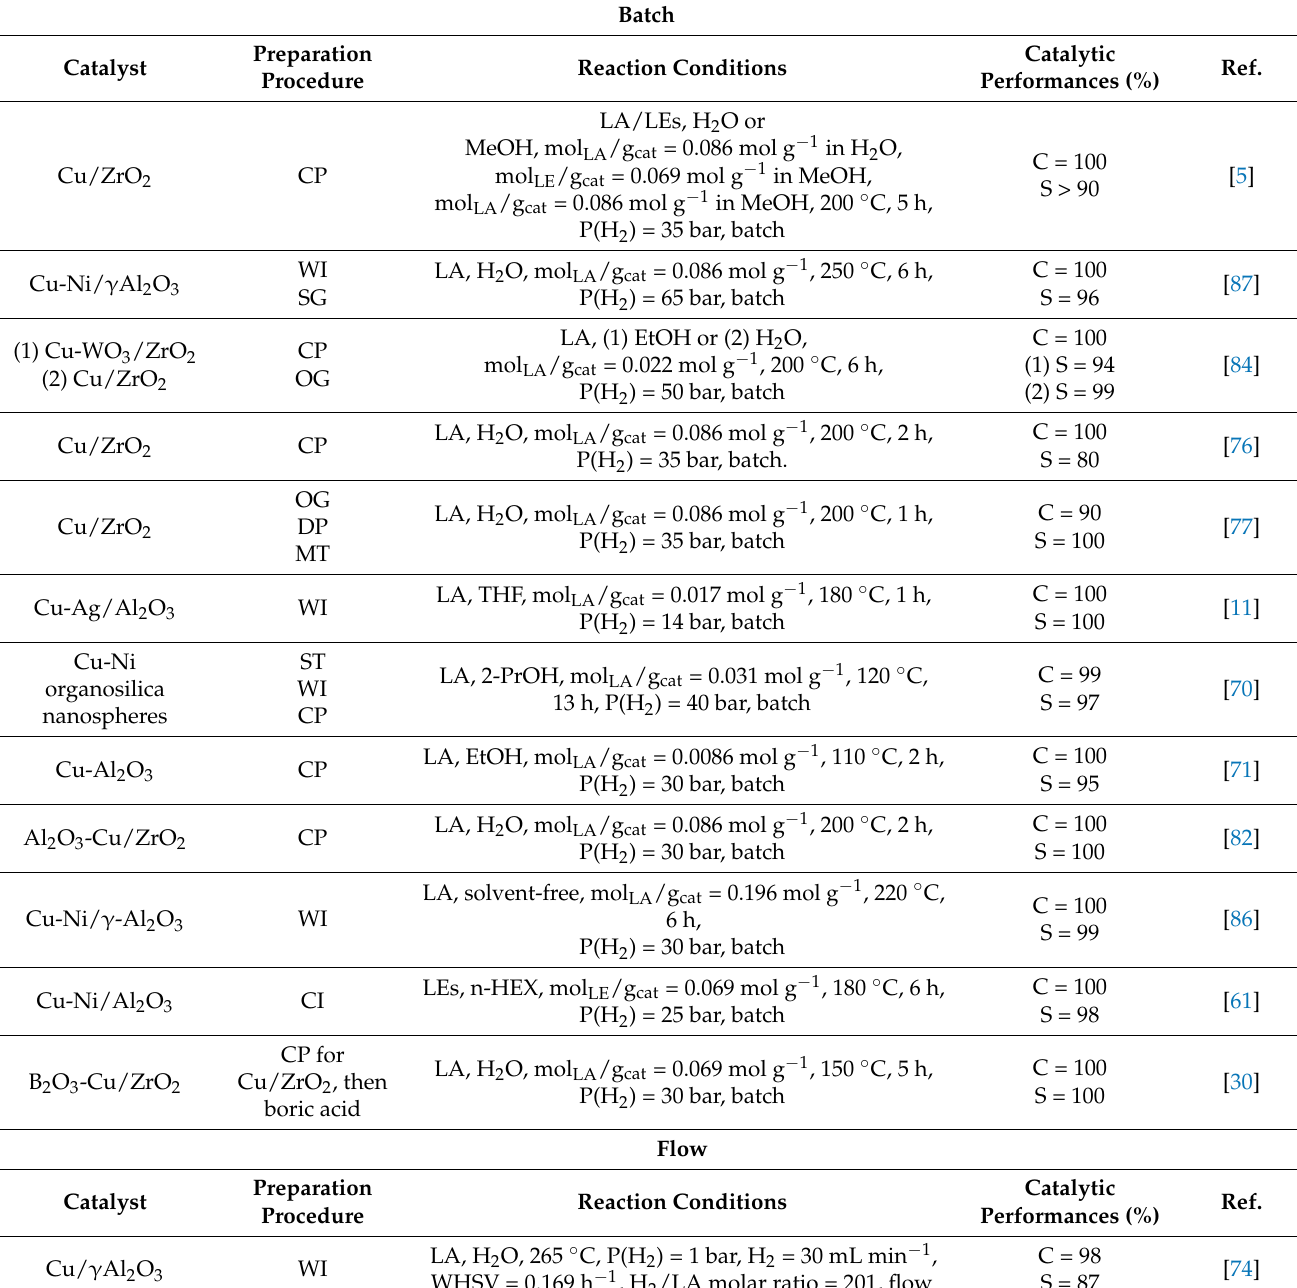
Table 1. Catalysts for the selective hydrogenation of LA/LE to